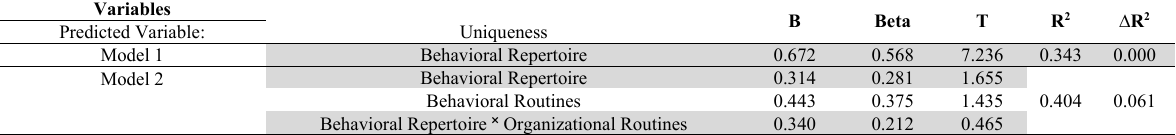
The results of Hierarchical Regression Analysis of the moderating effect of organizational routines on the relationship between behavioral repertoire and Uniqueness